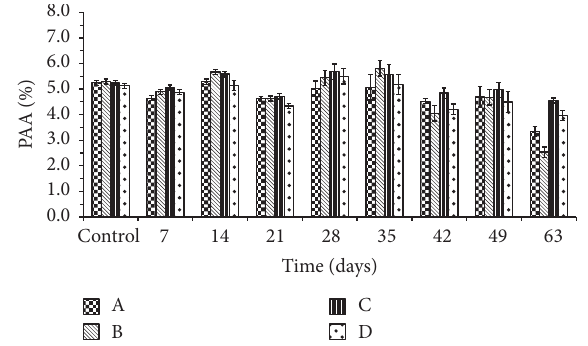
Figure 4: Evolution of peroxyacetic acid (PAA) in the biocide samples during stability